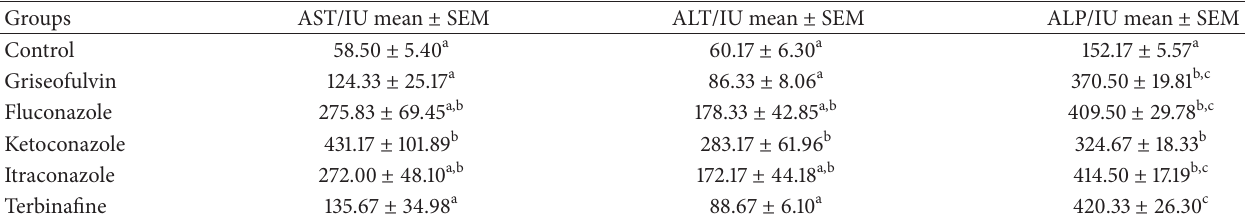
Table 1: Effect of the five oral antifungal agents (griseofulvin, fluconazole, ketoconazole, itraconazole, and terbinafine) on serum activities of AST, ALT, and ALP in rats after 14 days of